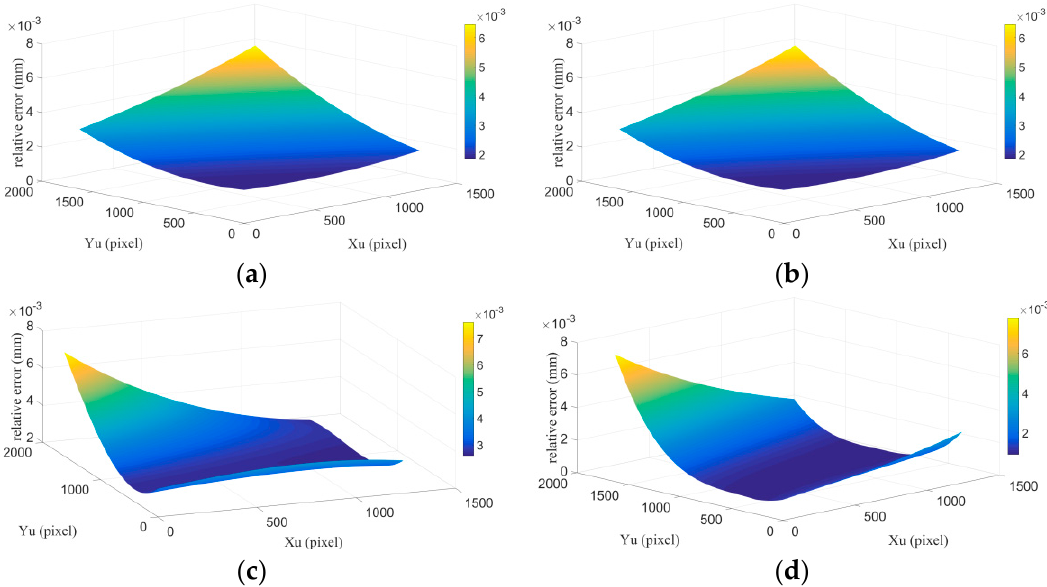
Figure 14. The repeatability experiment results. ( a – d ) represent the relative errors of the four experiments compared with experiment 1 at different pixel coordinates.